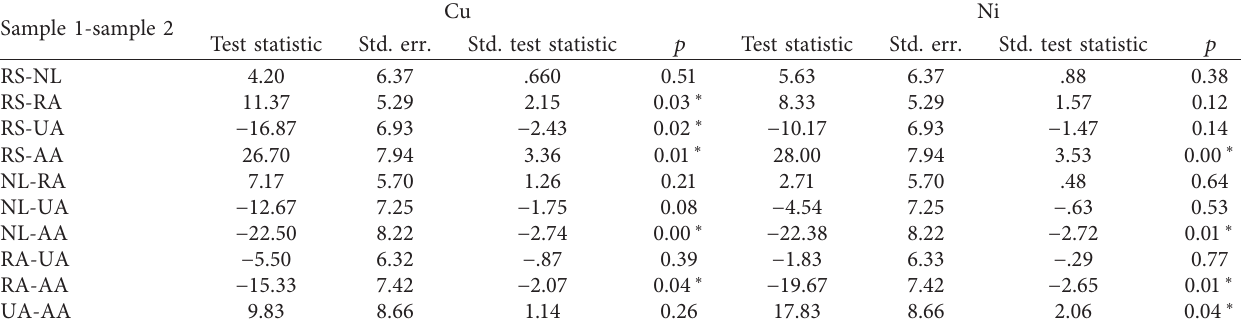
Sample 1-sample